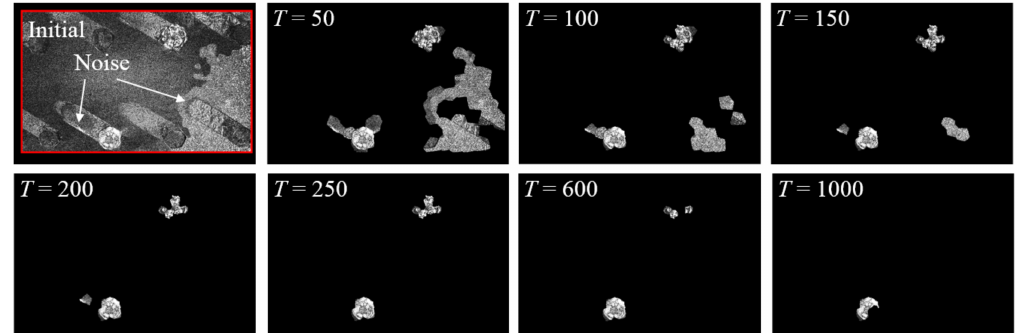
Figure 14. The initial bolt loosening features and results after applying a cutoff threshold T with magnitudes of 50, 100, 150, 200, 250, 600, and 1000, respectively. The brightness of all images is enhanced for demonstration purposes. The red block in Figure 14a is the